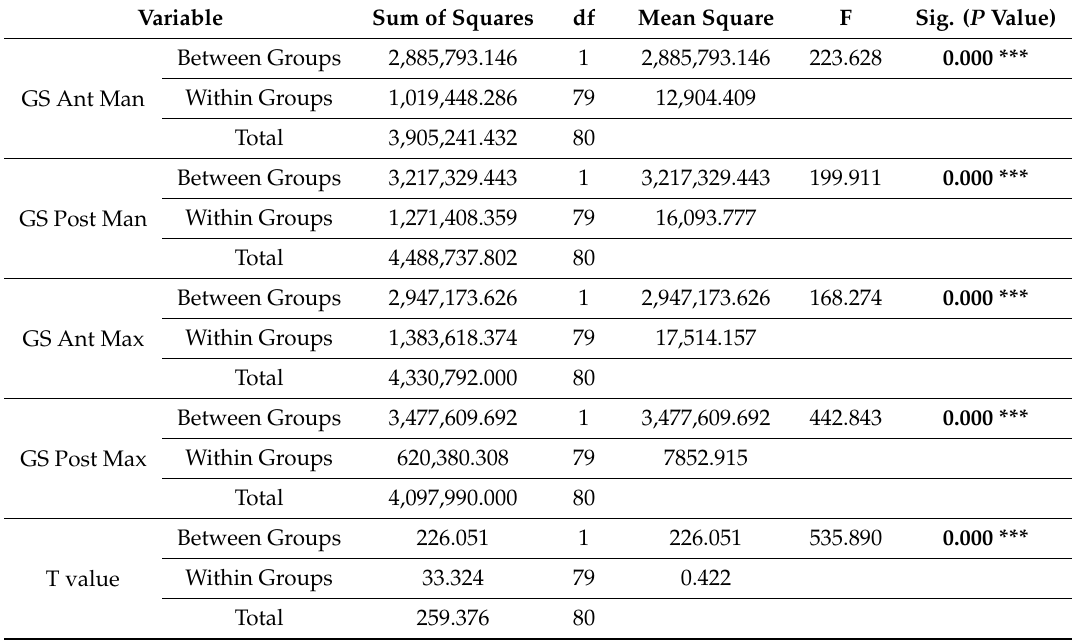
Table5. Analysisofvariance(ANOVA)ofTvalueandGSvaluesatdi ff erentjawregionsbetweengroups.